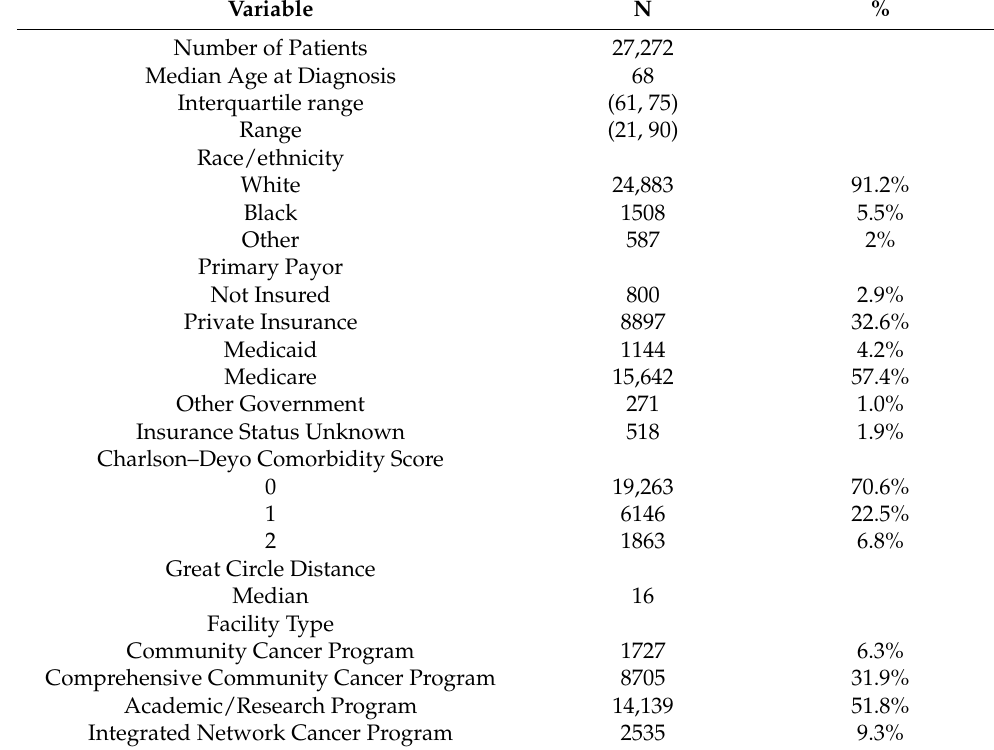
Table 1. Patient